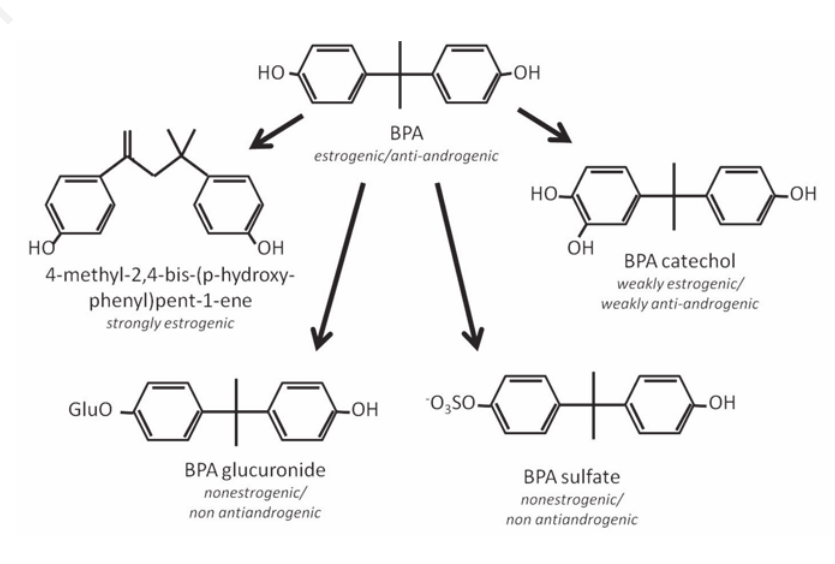
Figure 1. Major metabolites of bisphenol A (BPA) and their ability as endocrine